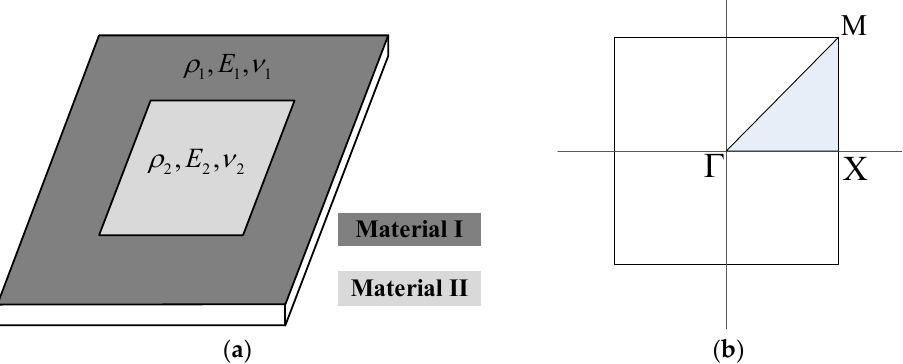
Figure 2. ( a ) The material arrangements of the two-dimensional lattice considered in this work; ( b ) the first Brillouin zone of the 2D periodic lattice; the grey section represents the irreducible region of the Brillouin zone.